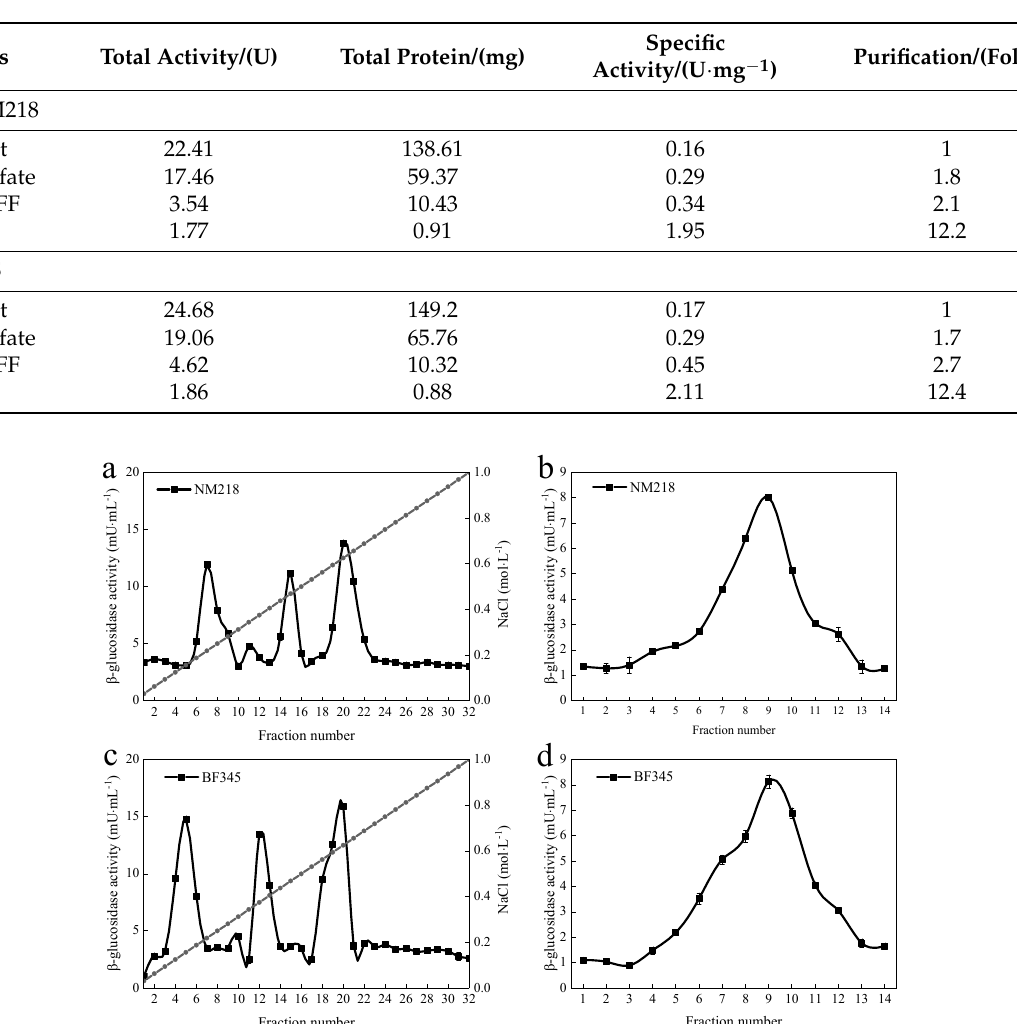
Figure 1. Purification of the β -glucosidase of M. guilliermondii NM218 and H. uvarum BF345. Fractions after DEAE-Sepharose-FF column (( a ) for NM218 and ( c ) for BF345) containing high β -glucosidase activity. Resulting peak fractions containing high β -glucosidase activity purified on Sephacryl S − 200 column (( b ) for NM218 and ( d ) for BF345). In both columns, the collected high β -glucosidase activity fractions are those having more than 5 mU/mL. The curve represents the enzyme activity, and the line represents the NaCl